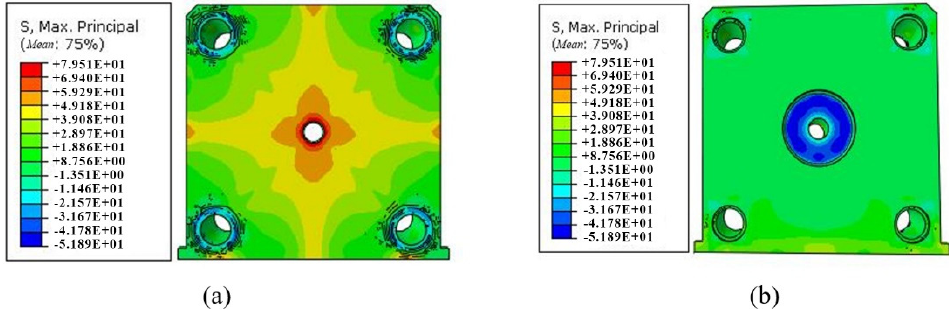
Figure 4. Stress distribution of the front beam (( a ) outside, ( b ) inside).